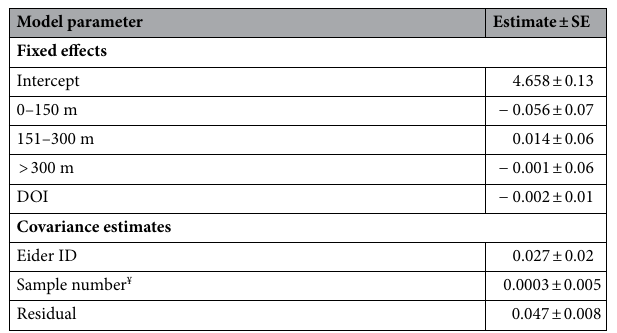
Table 1. Model parameter estimates for effect of drone distance category (controlling for reproductive investment; DOI – date of incubation) on heart rates of nesting Common eiders ( Somateria mollissima ). Estimates obtained from 93 observations across 11 individual eiders. Distance categories are compared to reference category that is the control period before drone flights occurred. ¥ Sample number nested within Eider ID.